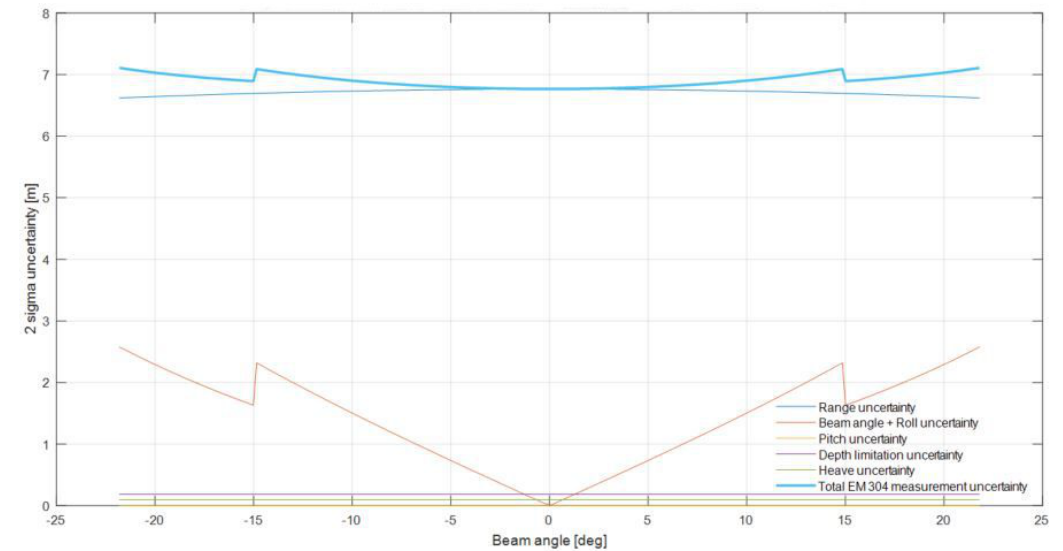
Figure 18. Uncertainties related to the EM 304 multibeam echosounder at the depth of 2500 m, for the swath width of 2000